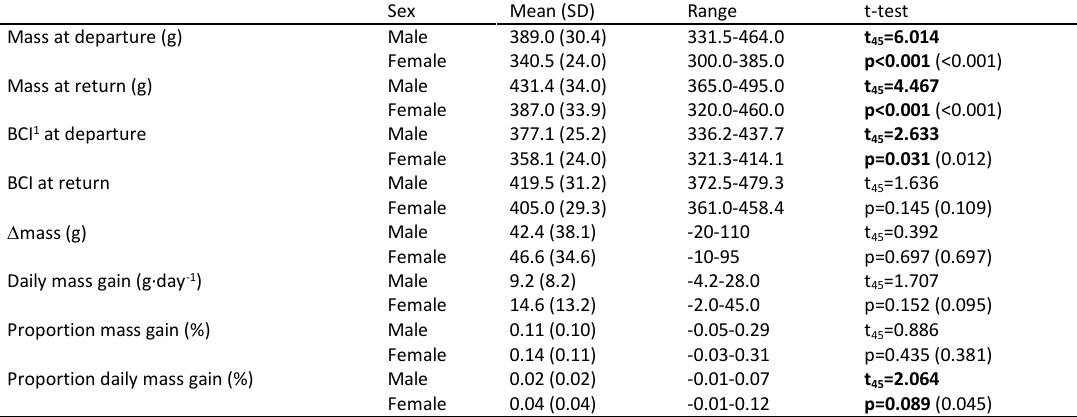
Table 8. Summary of metrics of foraging trip efficiency for snow petrels from Ile des Pétrels, Adélie Land, East Antarctica. For t-tests homogeneity of variances we checked using a Brown and Forsythe tests (Brown and Forsythe 1974), corrected p values are reported (uncorrected in brackets). Significant differences with a false detection rate of 0.10 are shown in